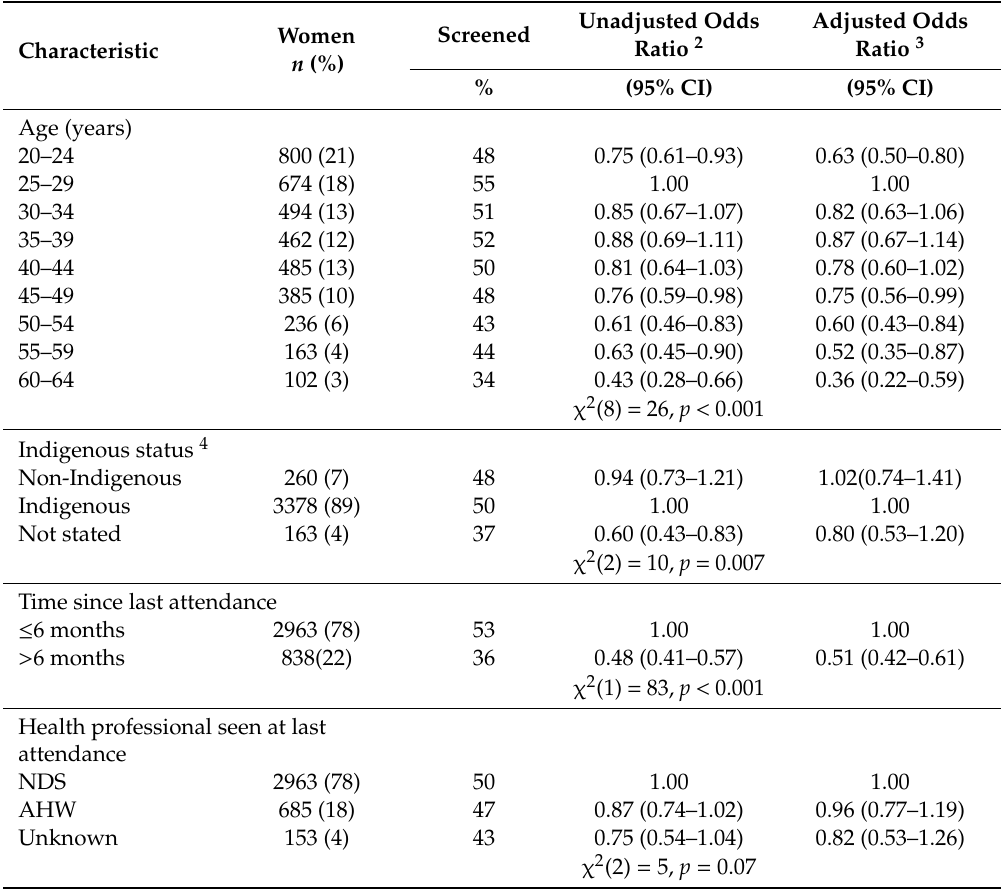
Table 2. Associations between characteristics of women ( n = 3801) attending Indigenous primary health care centres ( n = 135) and cervical screening in the previous two years 1